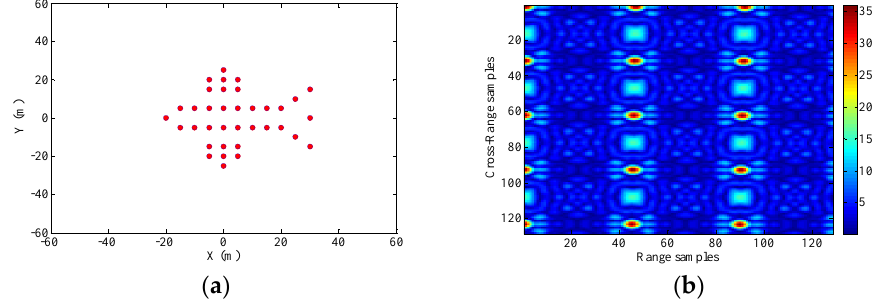
Figure 4. ( a ) A hypothetical target composed of perfect point scatterers. ( b ) The amplitude of the raw data.